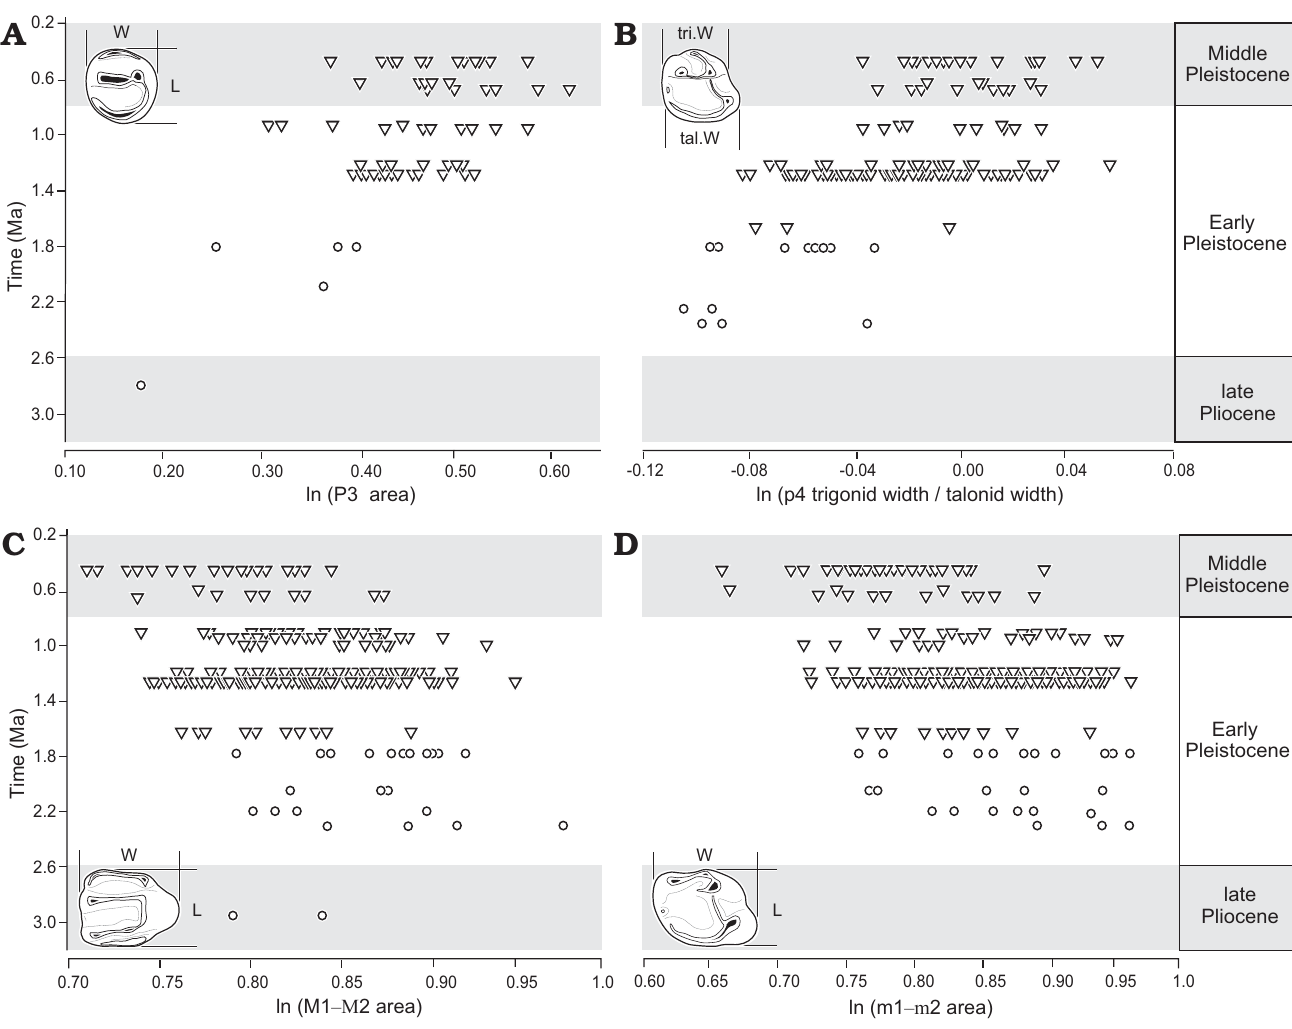
Fig. 9. Stratigraphic record of P3 ( A ), p4 ( B ), M1–M2 ( C ), and m1–m2 ( D ) sizes of Spermophilus praecox sp. nov. (circles) and Spermophilus nogaici (Topachevsky, 1957) (triangles). Abbreviations: L, length; W, width; tal.W, talonid width; tri.W, trigonid